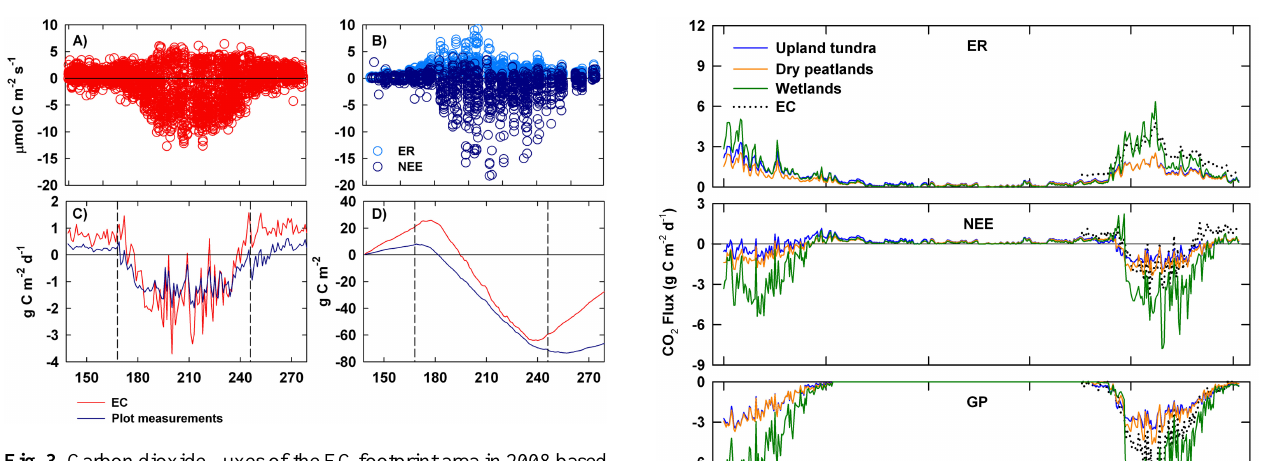
Fig. 3. Carbon dioxide fluxes of the EC footprint area in 2008 based on EC (red) and plot-scale measurements (chambers, snow gradient and lake measurements; blue). (A) Non-gap-filled half-hourly NEE from EC; (B) raw chamber data: NEE under ambient and reduced light and ER; (C) daily NEE fluxes by the two methods; (D) cu- mulative NEE by the two methods. Positive values indicate C loss from the ecosystem, negative values C uptake. The daily and cumu- lative plot-scale fluxes have been integrated over time with regres- sion functions and area-weighed for the EC footprint using the land cover classification. The dashed lines indicate the start and end of the growing season.